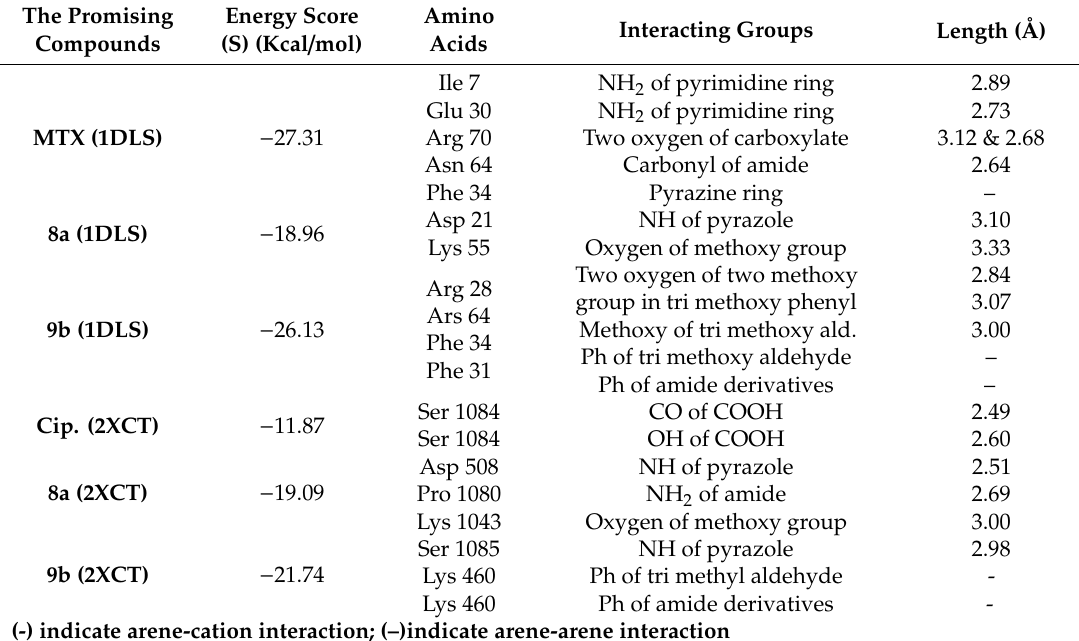
Table 9. Docking results of the promising pyrazole Schi ff bases inside 1DLS and 2XCT active site. The